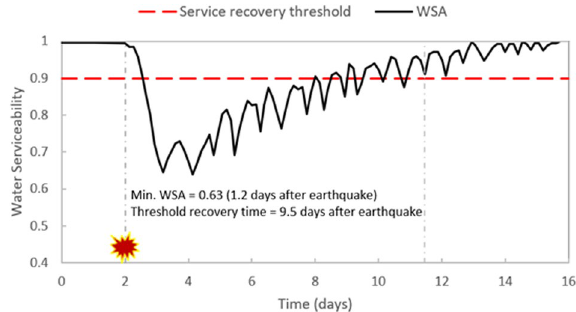
Figure 9. WDN water serviceability represented by the median of 50 realization for the scenario of 5.5 M earthquake at Location 1 with repair strategy RS2.